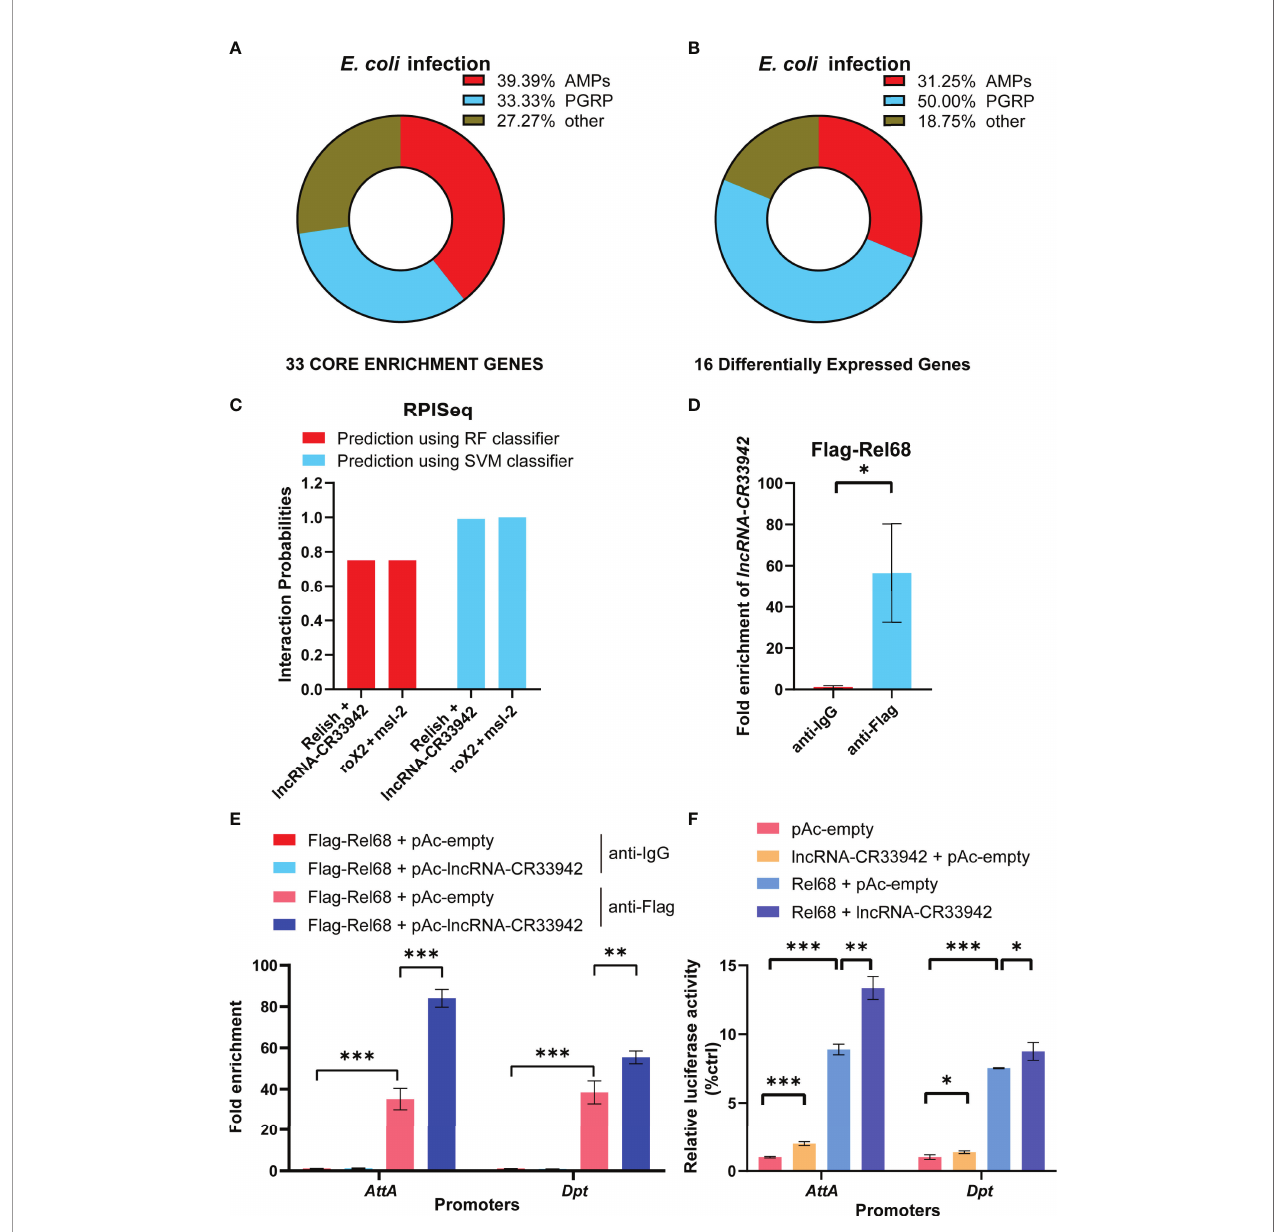
FIGURE 3 | lncRNA-CR33942 promotes Relish binding to the AMPs promoter via interaction. Classi fi cation analysis was performed on 33 core enriched genes from GSEA results (A) and 16 DEGs (B) . (C) Predicted scores for interaction potential of lncRNA-CR33942 with Relish via RPISeq databases. (D) lncRNA- CR33942 enrichment fold was measured by RIP-qPCR using anti-Flag antibody to immunoprecipitate overexpressed Flag-Rel68 in S2 cells. (E) ChIP-qPCR was performed on lncRNA-CR33942 -overexpressing S2 cells with Flag-Rel68 overexpression normalized to control expression levels. (F) The dual-luciferase reporter assays were performed to detect the transcriptional activity of Rel68 on Dpt and AttA promoters with or without lncRNA-CR33942 overexpression or only overexpressing lncRNA-CR33942 . *P < 0.05; **P < 0.01; ***P <